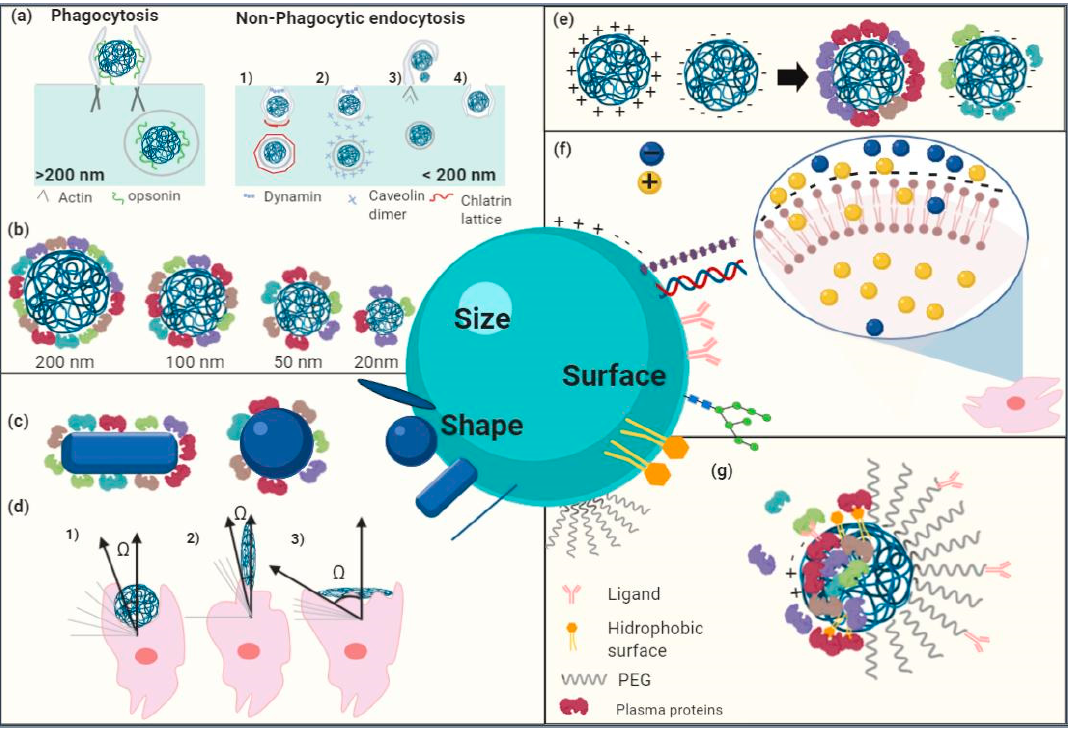
Figure 6. Physiochemical properties of PNs influenced by physiological conditions (and vice versa). ( a ) Size effect on endocytosis pathway. Large particles are uptaken by phagocytosis and smaller particles by non-phagocytic endocytosis, i.e., chlatrin-mediated endocytosis (a1), caveolar-mediated endocytosis (a2), macropinocytosis (a3), and chlatrin- and caveolin-independent endocytosis (a4). ( b ), ( c ) and ( e ) Size and shape effect, superficial area increases adhesion of plasma proteins. ( d ) PNs shape module the macrophages’ phagocytosis, which lead to internalization or simply spread on particles: when Ω is less than or equal to 45°, particles are internalized successfully (d1, d2), when Ω is greater than 45°, cells spread on the particle and internalization is inhibited (d3). ( f ) Surface charge impact PNs’ cellular uptake, cells uptake easier with cationic particles that interact with anionic charges of the cell membrane. ( g ) Hydrophilic steric barrier and neutral superficial charge of PEGylated PNs decreases plasma protein adhesion.